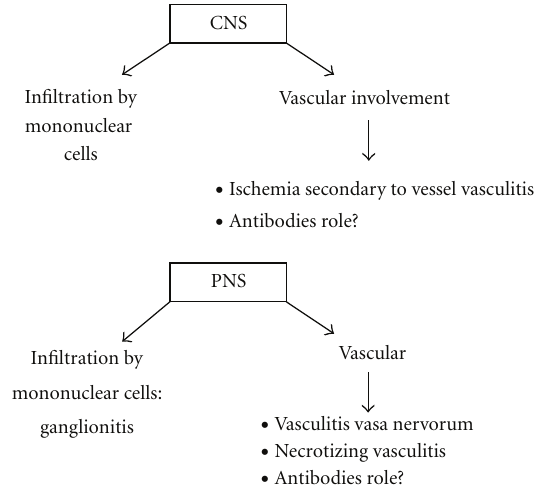
Figure 1: Pathophysiological mechanism implicated in the devel- opment of central and peripheral nervous system manifestations in primary Sj¨ogren’s